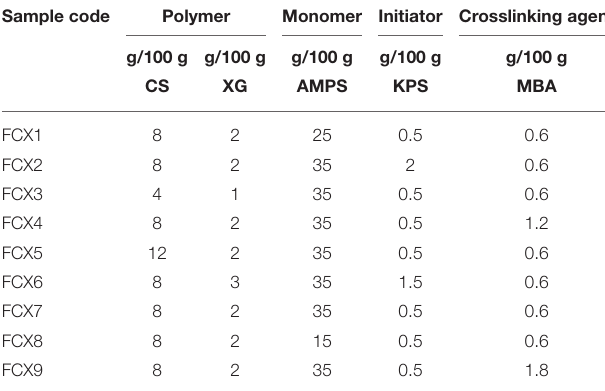
TABLE 1 | Hydrogels (FCX1-FCX9) using different concentration of